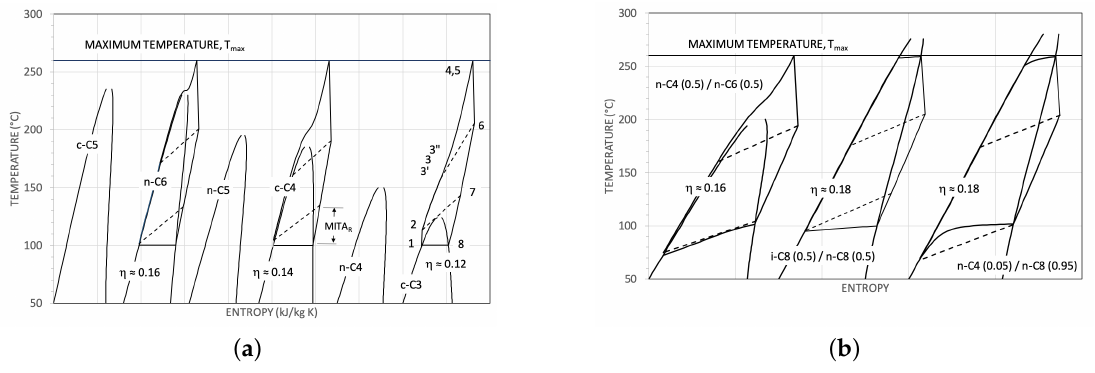
Figure 7. ( a ) Configuration of some (supercritical) thermodynamic cycles in the T − S plane (pure fluids); ( b ) Configuration of some thermodynamic cycles in the T − S plane for hydrocarbon mixtures. The mixture n-C4 (0.5)/n-C6 (0.5) (see Figure 5c) at a condensing pressure P E of 4.4 bar has a